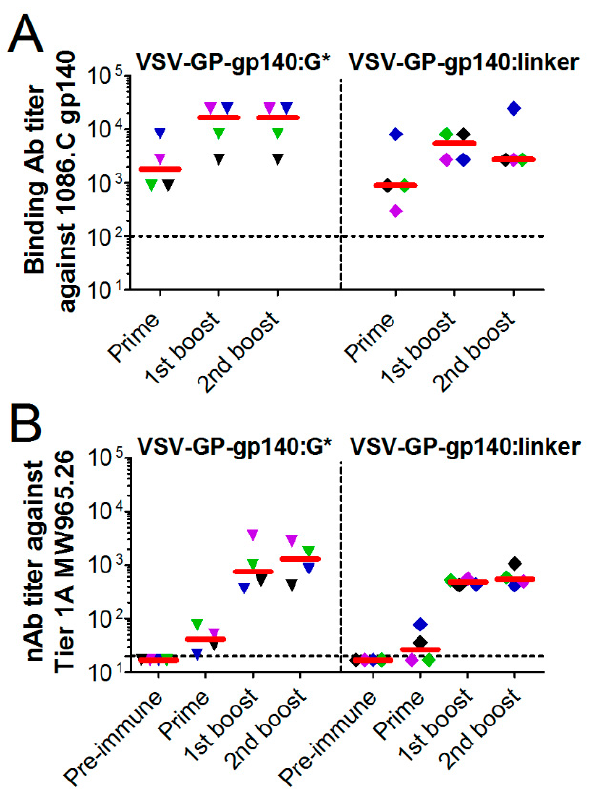
Figure 6. VSV-GP-Env induces gp140 binding antibodies upon immunization of rabbits. New Zealand White rabbits ( n = 4) were immunized intramuscularly with 2 × 10 8 TCID 50 of VSV-GP-gp140:G* or VSV-GP-gp140:G-linker at week 0, 3, and 6. ( A ) Prior to the first immunization and three weeks after each immunization plasma was collected and analyzed for the titer of gp140-binding antibodies using an ELISA. ( B ) Serum samples prior to the first immunization and three weeks after each immunization were analyzed for the titer of neutralizing antibodies against the Clade C Tier 1A HIV-1 MW965.26 virus using a TZM-bl neutralization assay. The median for each group (red line) and the titer for each individual animal are shown. The same colored symbol is used for each animal at different time points. The dotted line shows the detection limit of the assay.